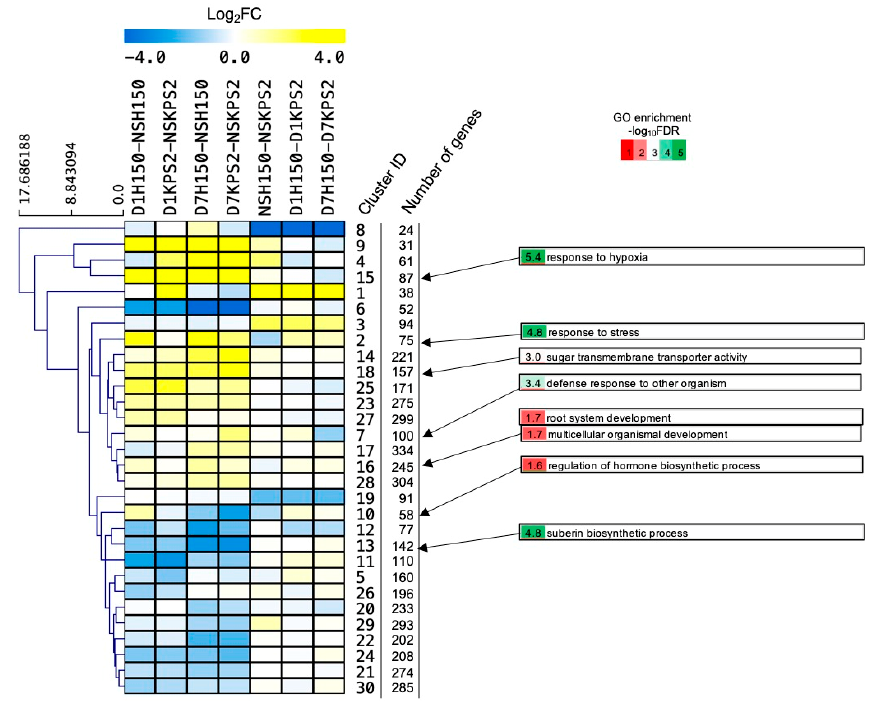
Figure 7. Fuzzy k-mean analysis of DEGs from roots of “H150” and “KPS” subjected to WS. The heat map shows median log 2 fold change values for 30 clusters of transcripts with similar regulation. Selected enriched GO terms were displayed. Data can be found in Table S6. Based on the pattern of gene expression and the GO term enrichment results, we placed our attention on Cluster#2 genes associated with “response to stress” and Clus- ter#16 genes related to “root system development” and “multicellular organismal devel- opment” (Figure 8). Interestingly, jasmonic acid (JA) and ethylene-responsive transcrip- tion factors that can activate root stem cells, ABR1 and RAP2.6L, were found in Cluster#2. In addition, a key enzyme for ethylene biosynthesis, ACC synthase ( Vradi11g01990 ), was also in Cluster#2. Two direct targets of auxin response factor (ARF) 7 and 19, LATERAL ORGAN BOUNDARIES DOMAIN 18 and 29 ( LBD18 : Vradi0122s00050; LBD29: Vradi08g08690 ), were found in Cluster#16. Several auxin-related genes with roles in the AR and LR formation, PLETHORA 3 ( PLT3 : Vradi11g09310 ), CYTOKININ RESPONSE FACTOR 2 ( CRF2: Vradi11g01790 ) , and SOMBRERO (SMB: Vradi05g18500), were also found in Cluster#16.